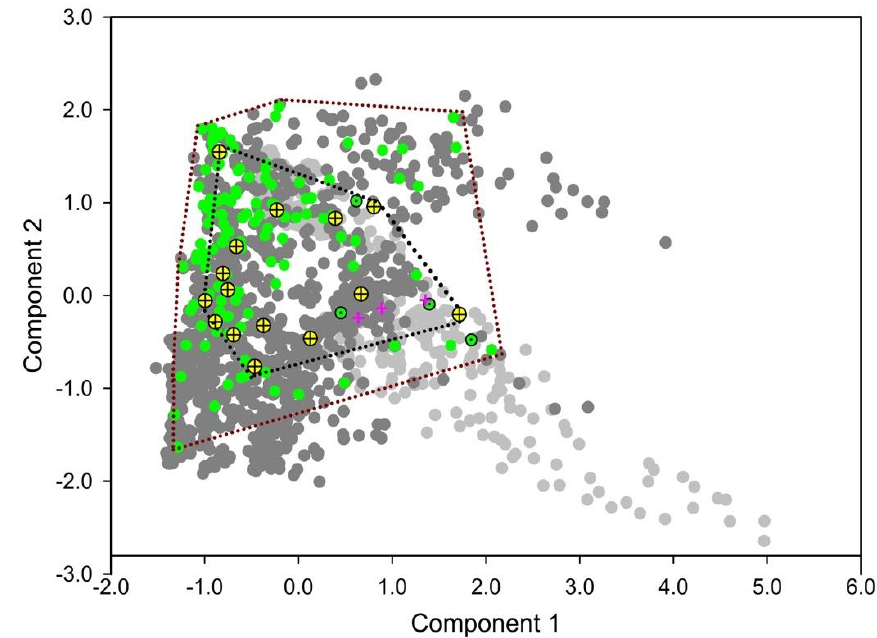
Figure 2. Comparison of climatic niches between native and introduced populations using principle component analysis. Green and green dotted circles represent native and invasive populations of tomato potato psyllid (TPP), respectively. Yellow crossed circles and pink plus symbols are native and invasive populations of Candidatus Liberibacter solanacearum (CLso), respectively. Light and dark gray dots depict random points generated from invaded and native backgrounds, respectively.